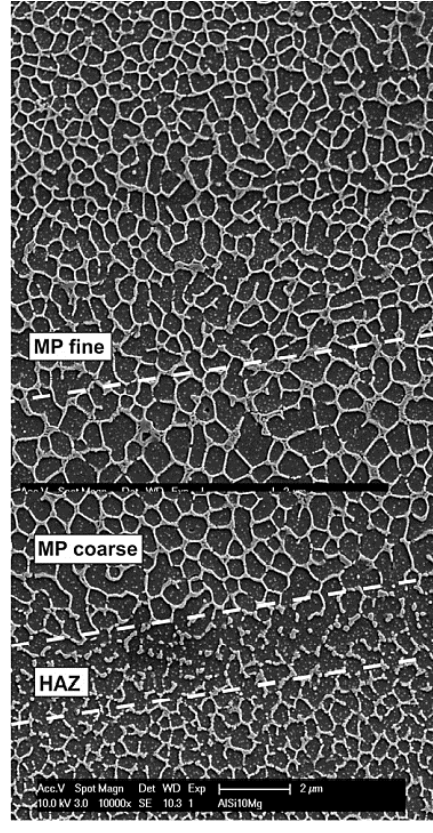
Figure 2. A Scanning Electron Microscope (SEM) image of the melt pool (MP) zone with fine (MP fine) and coarse (MP coarse) microstructures and a heat affected zone (HAZ) in the boundary with the previously fused layer. Reproduced from [13] with permission from Elsevier.